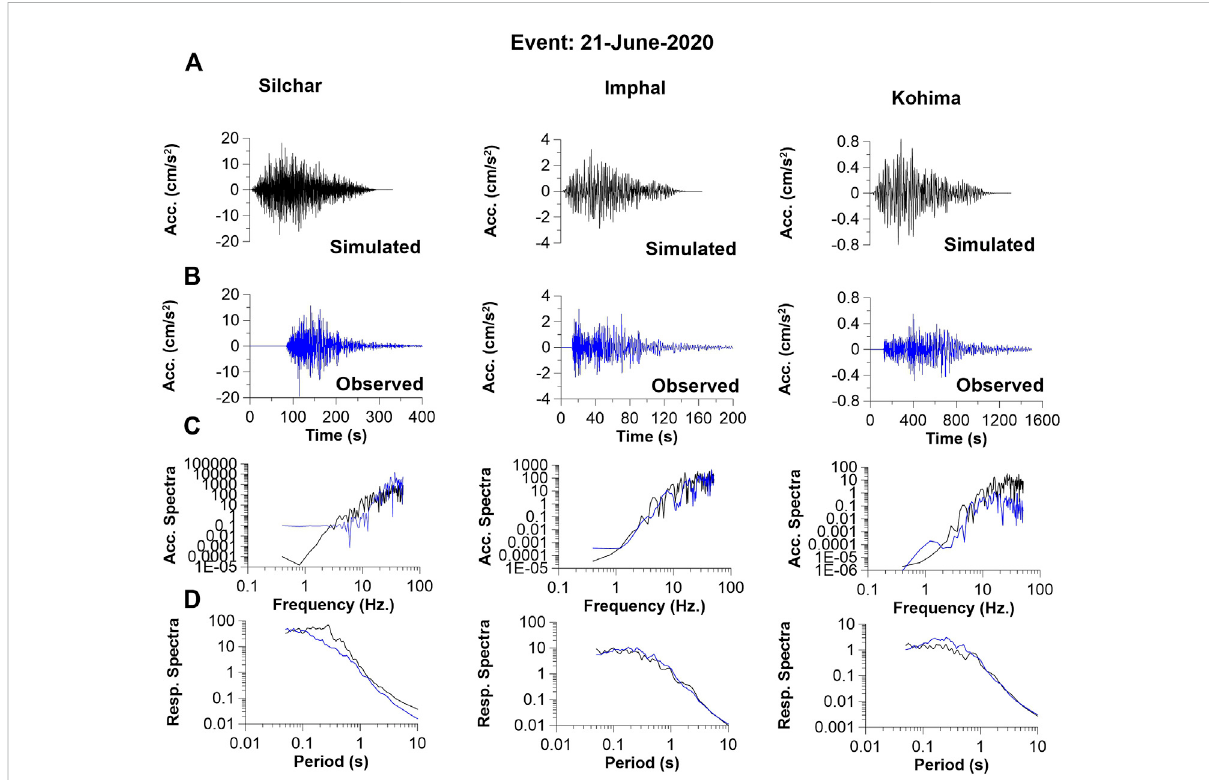
FIGURE 4 Comparative plot between (A) simulated (black lines) and (B) observed (blue lines) acceleration waveform records. (C) acceleration spectraand (D) responsespectraforsimulated(blacklines)andobserved(bluelines)groundmotionrecordsatthreestations,namelySilchar,ImphalandKohima of the 21 June 2020 (M5.7) event.